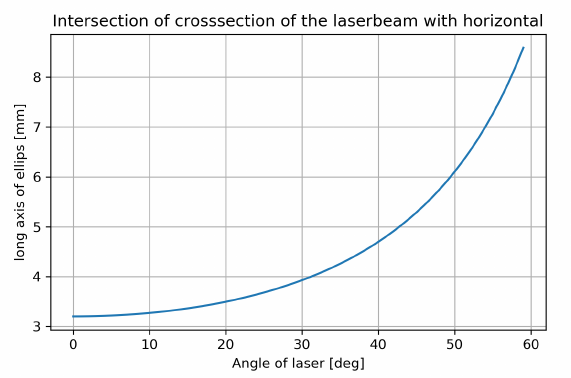
Figure 5. Effect of the angle of the beam on the beam width. A larger angle causes a larger beam